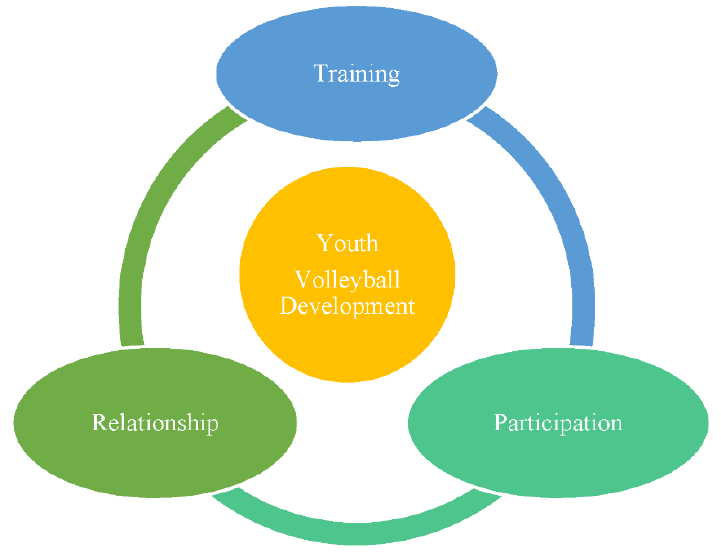
Figure 3. Process evaluation components.